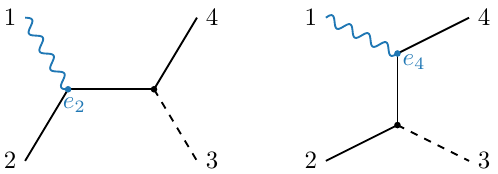
Figure 4: Feynman diagrams of the s - and t -channel contributions to photon-induced pion